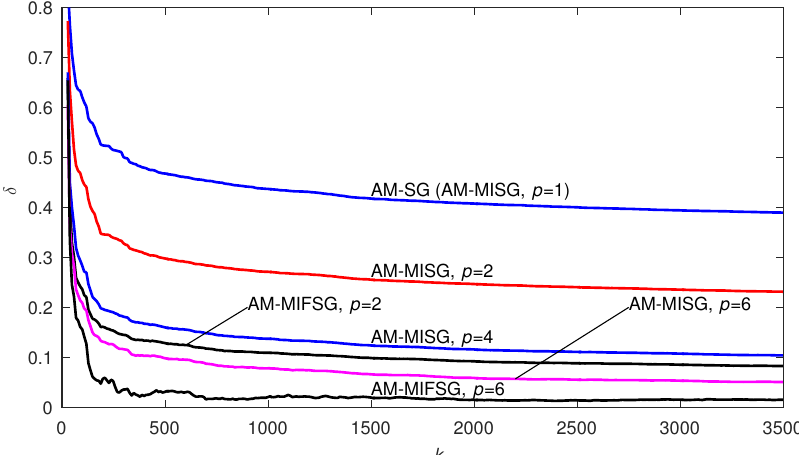
Figure 2. The AM-MISG estimation error δ versus k with p = 1, 2, 4 and 6 and the AM-MIFSG estimation error δ versus k with p = 2 and